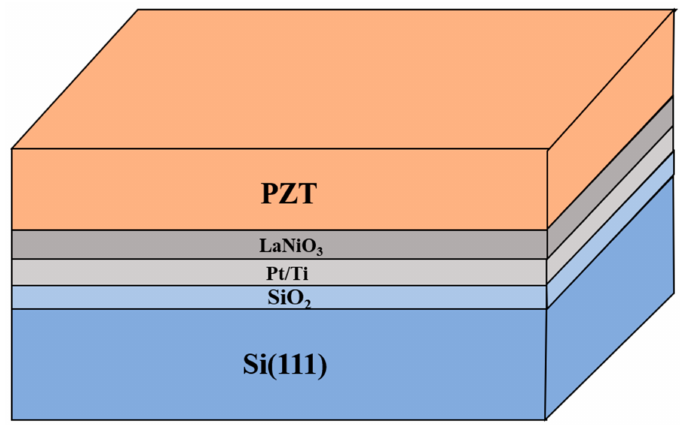
Figure 1. Diagram of the PZT/LaNiO 3 /Pt/Ti/SiO 2 /(111)Si heterostructure. The phase structures and crystallographic orientations of the PZT films were detected by using XRD θ -2 θ scans (Rigaku Dmax-2500 PC XRD diffractometer equipped with a Ni-filtered Cu K α radiation source, Tokyo, Japan). Nanostructures of the PZT films were investigated via scanning electron microscopy (SEM, Sigma 300, Zeiss, Oberkochen, Germany) and transmission electron microscopy (TEM, JEM-2010, JEOL, Tokyo, Japan), respectively. Cross-sectional SEM images of the PZT films were compared head to head, from which the grain morphology and its evolution with the annealing time were